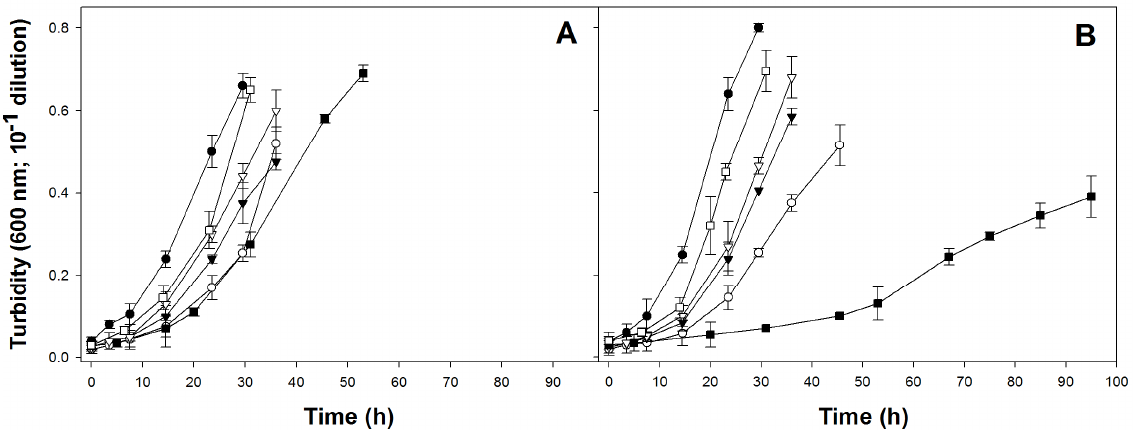
FIGURE 2. Growth of each mutant strain on mannitol (A) and Man+Benz (B) medium. M1 ( (cid:1) ), M2b ( (cid:2) ), M2c ( (cid:1) ), M3 ( (cid:2) ), M5b ( (cid:3) ), and M6b ( (cid:4) ). Where SD error bars are not shown, it is because they were smaller than the symbol.